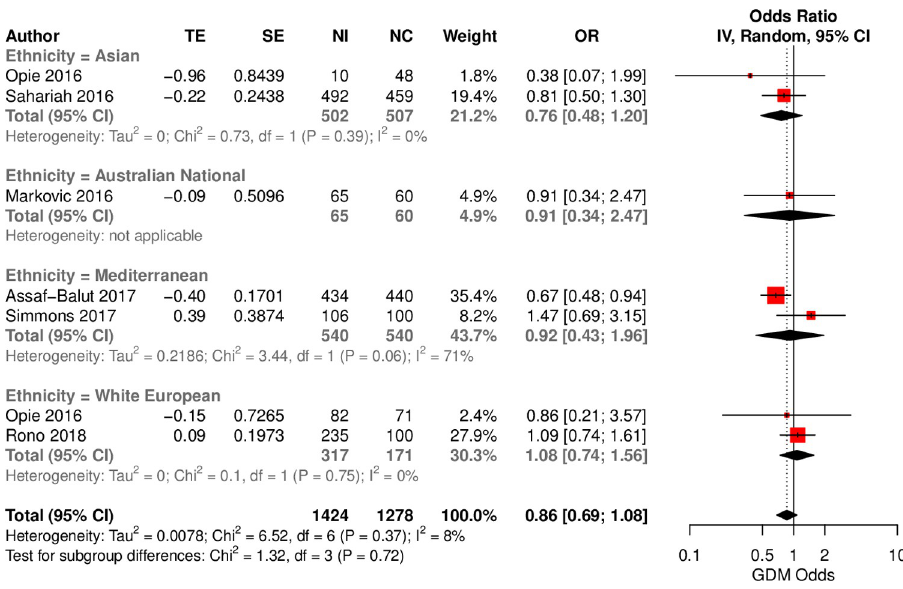
Fig 2. Forest plot of reported effect sizes of healthy dietary interventions on GDM in ethnic–specific RCTs. Forest plot to investigate the association between heathy diets and GDM, investigated within distinct ethnic groups. TE: treatment effect, SE: standard error, IV: inverse variance method, CI: Confidence